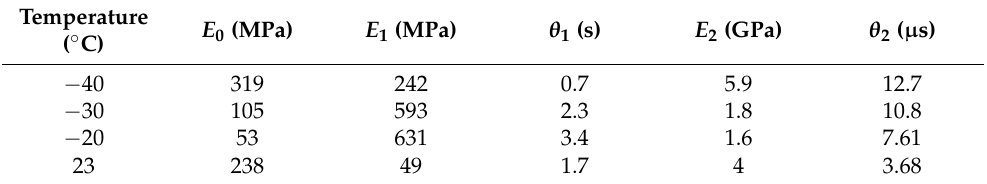
Figure 21. Comparison of the fitting results of the ZWT constitutive model with the experimental results under different strain rates at − 40 °C: ( a ) 1400 s − 1 ; ( b ) 2000 s − 1 . Table 5. Parameters of the reinforced Al/PTFE constitutive model at different temperatures.